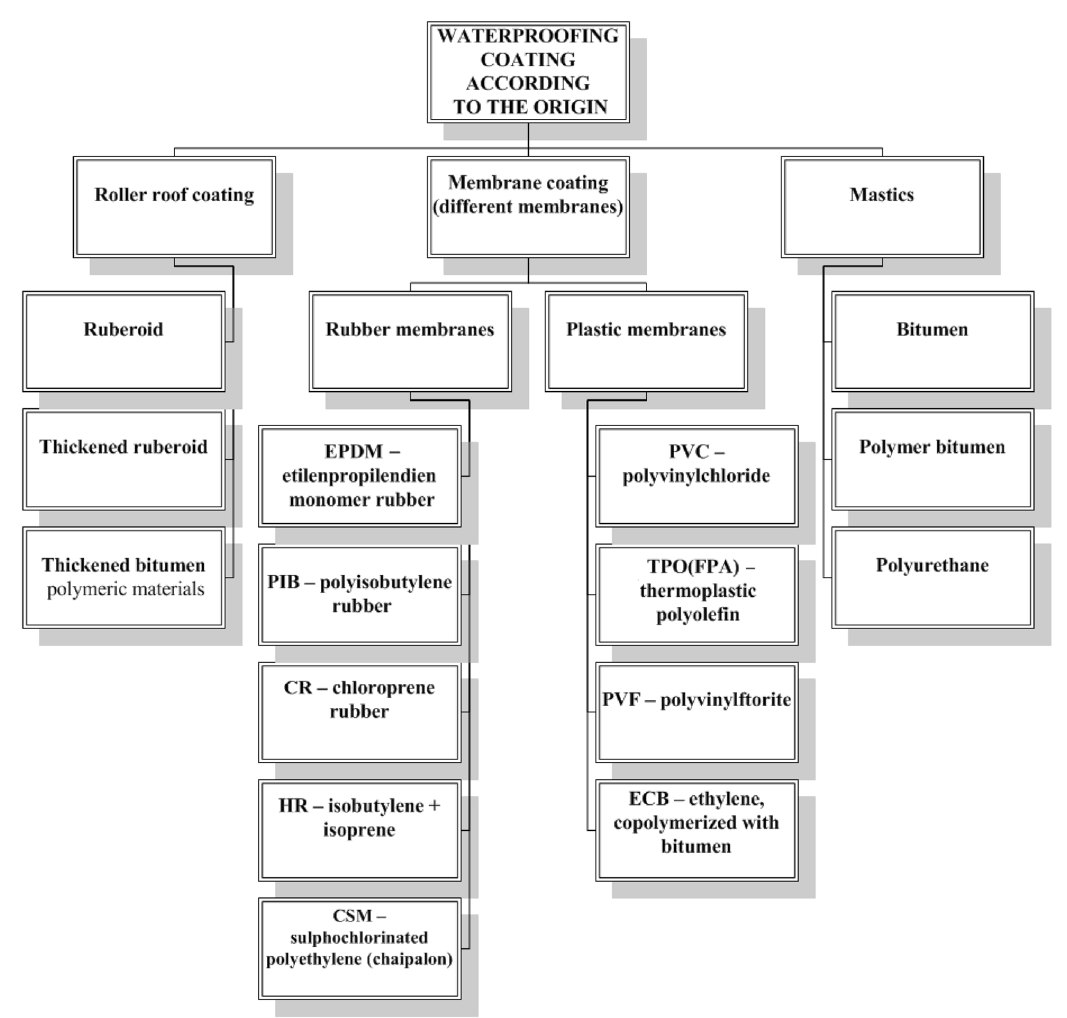
Fig. 3. Classification of waterproofing coatings by origin